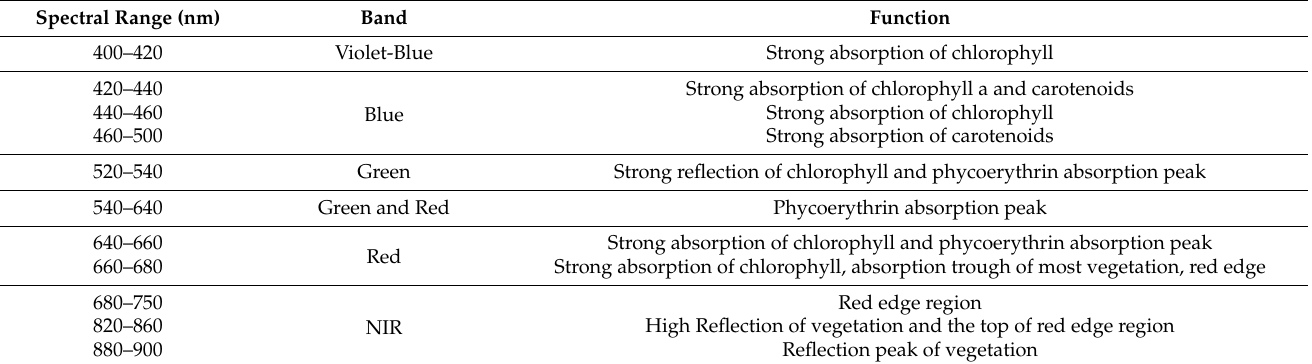
Table 2. Key wavebands for vegetation detection in the visible-near infrared range (400–1000